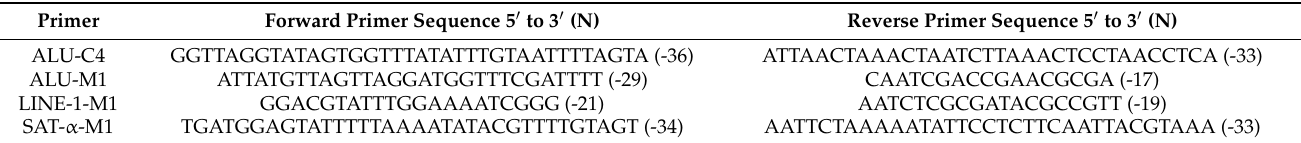
Table 1. Primers information [37].